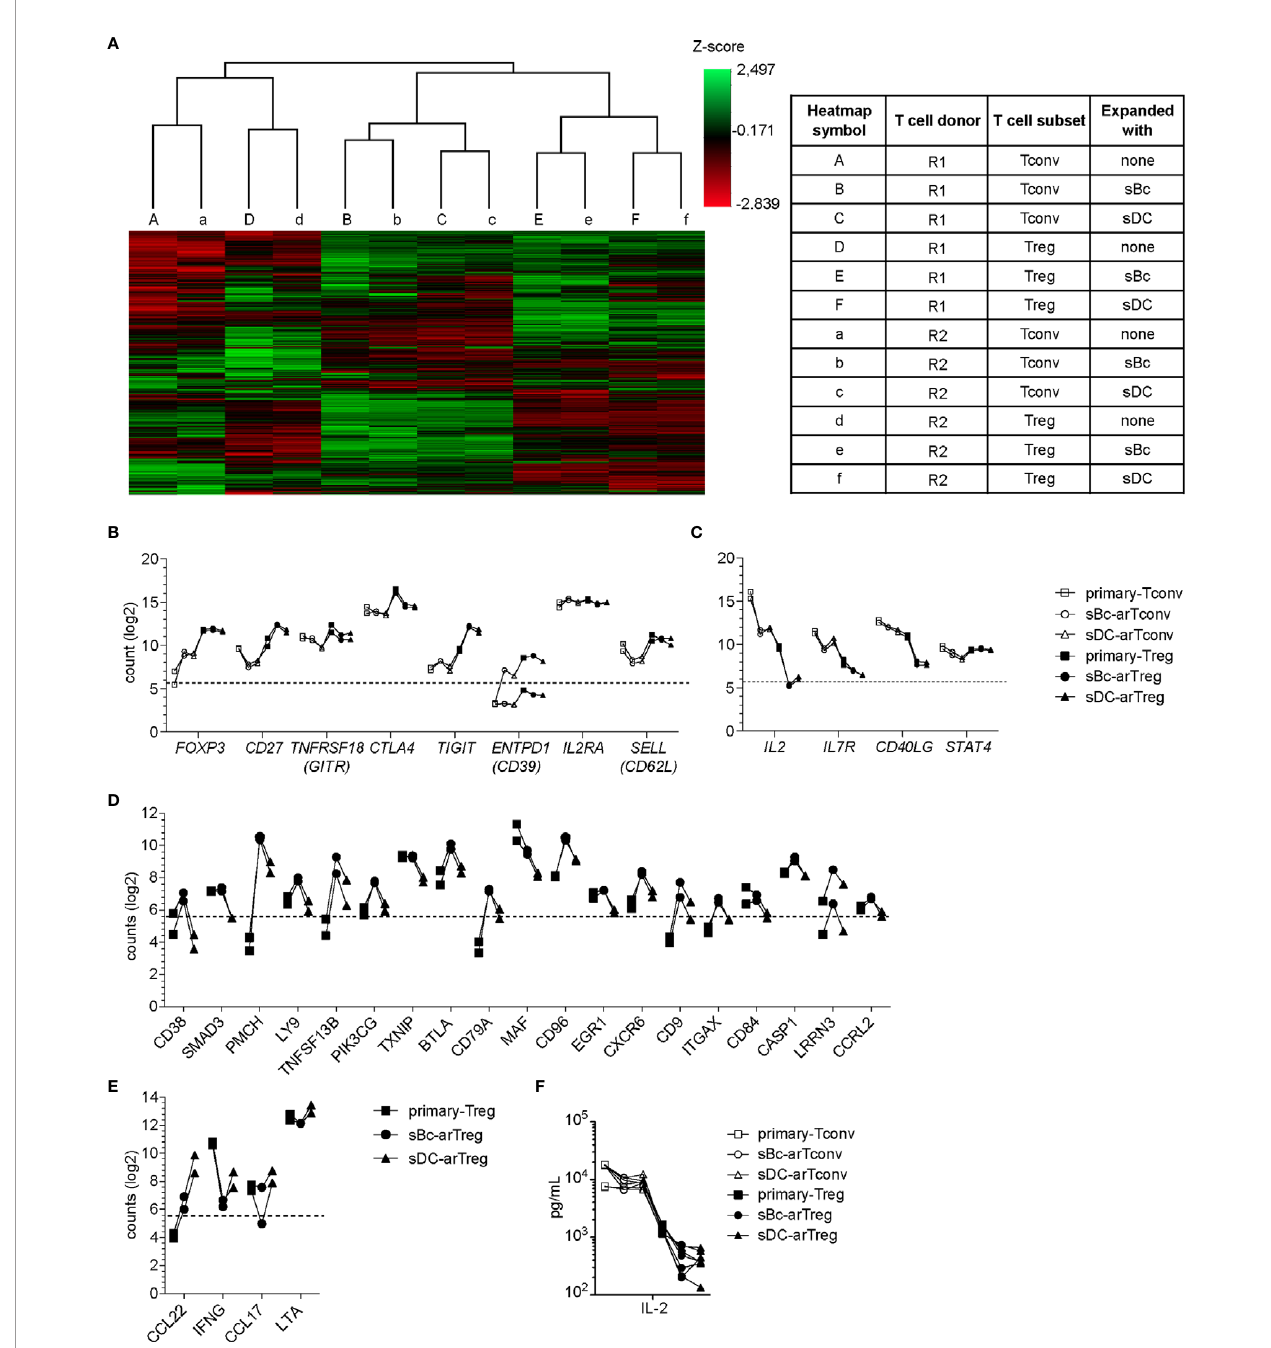
FIGURE 4 | sBc- and sDC-arTregs maintain their Treg identity after restimulation. (A – F) FACS-puri fi ed T cells (primary-Tregs and primary-Tconvs) and cultured alloreactive T cells were stimulated with anti-CD3/CD28 beads for 24 h. (A – E) RNA was harvested from stimulated cells and analyzed using Nanostring ’ s PanCancer Immune Pro fi ling Panel. (A) Heatmap generated from unsupervised clustering analysis of 439 normalized gene expression data (left). Description of T cell subsets and APC stimulation (table, right) (B) Gene expression of Treg-associated molecules. (C) Gene expression of Tconv-associated molecules. (D) Genes differentially expressed at least 2-fold greater in sBc-arTregs compared to sDC-arTregs. (E) Genes differentially expressed at least 2-fold less in sBc-arTregs compared to sDC- arTregs. (F) Supernatants from stimulated cells were collected and analyzed for IL-2 using Luminex assay. Data in (A – F) contain 2 different responder-stimulator combinations. Values above the dotted line are above background expression. Data in (F) contain 7 different responder-stimulator combinations. Connecting lines indicate alloreactive T cells stimulated by APCs (sBcs or sDCs) derived from the same donor. Statistics in (F) were performed between sBc-arTregs and sDC-arTregs using the Wilcoxon matched-pairs signed rank test. Data from primary T cells and arTconvs are shown as reference and were not included in statistical